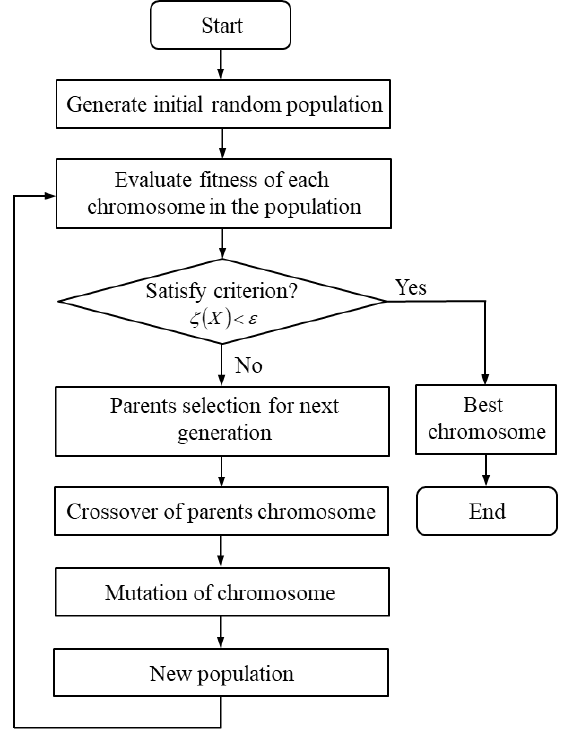
Figure 1. Flowchart of the genetic algorithm.